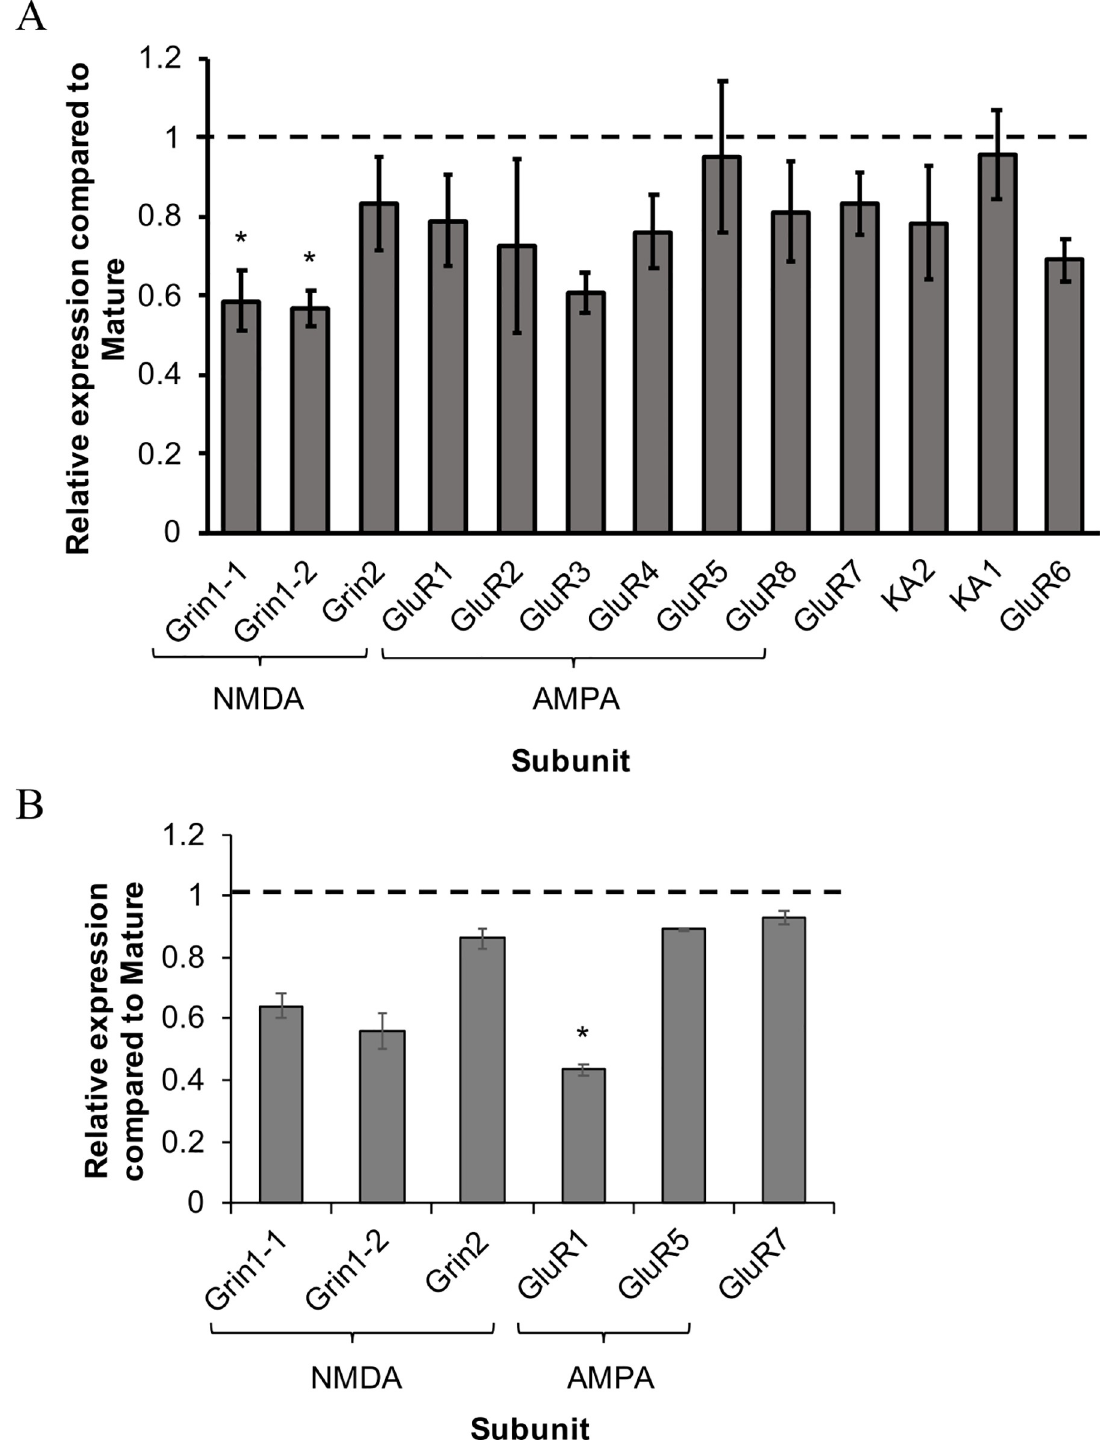
Fig 2. Relative expression of iGluR subunits in BSC sensory neurons with age. A) Relative expression for all iGluR genes in AII BSC sensory neurons compared to M (dotted line) in cohort 1. B) Relative expression for select subunits iGluR subunits in AII BSC sensory neurons compared to M (dotted line) in cohort 2. All data are presented as mean relative expression ± SEM. � denotes significantly reduced expression compared to M (p � 0.05, two-way ANOVA, Tukey’s post hoc; n = 6 for cohort 1, n = 4 for cohort 2).